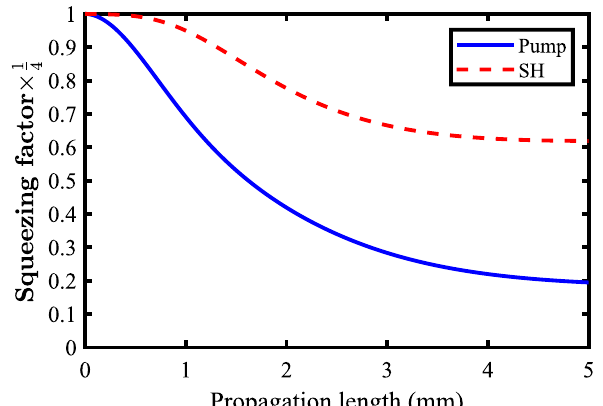
Figure 6. Pump (blue-solid line) and the SH mode (red-dashed line) squeezing through the nonlinear plasmonic waveguide proposed in Fig. 2. Here, the initial pump power ( P 0 ) is 1 W .